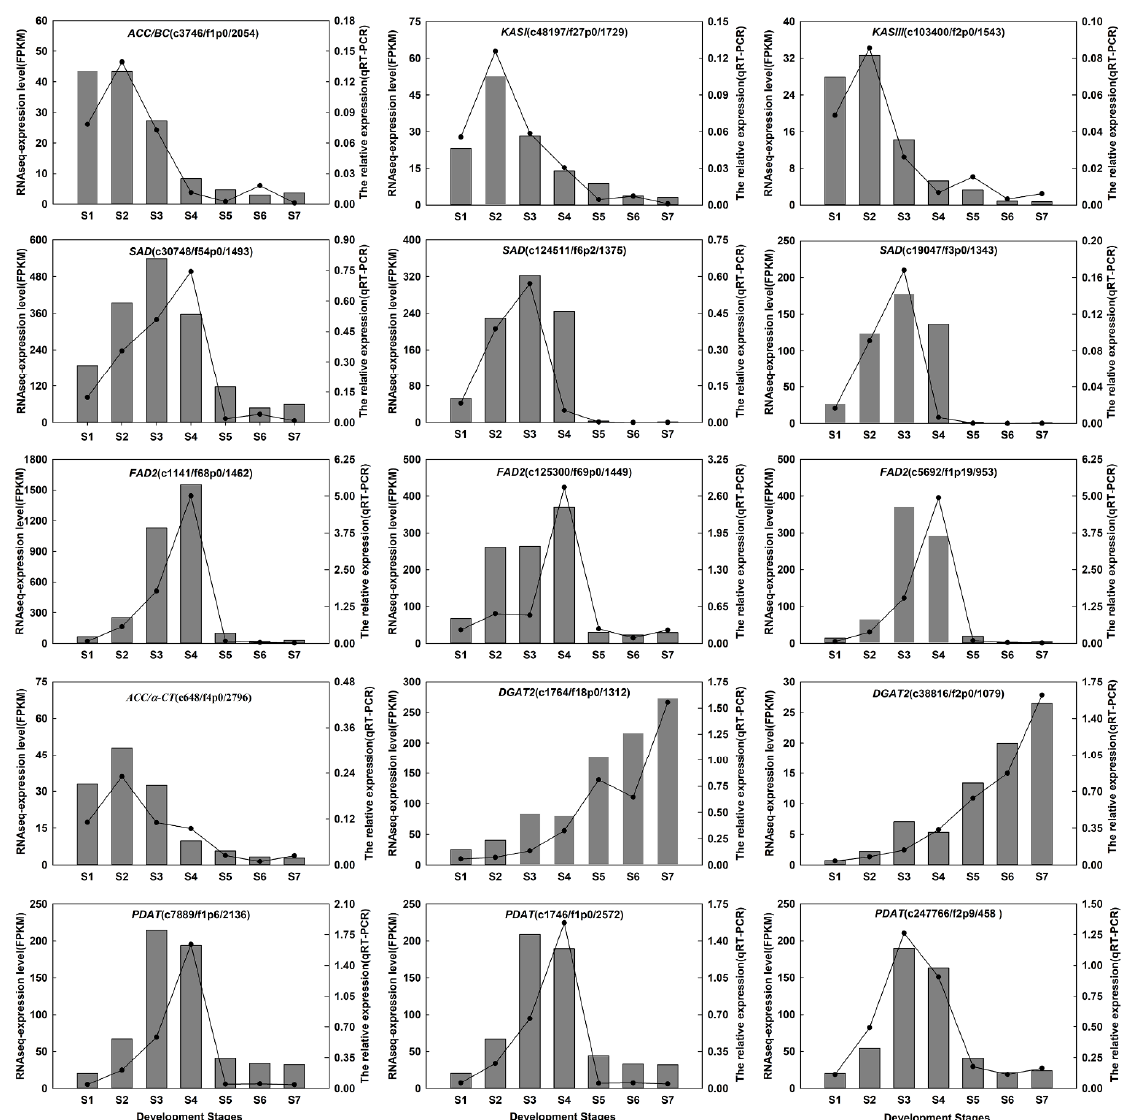
Figure 8. qPCR validation of fifteen candidate genes associated with oil biosynthesis during A. sphaerocephala seed devel- opment.